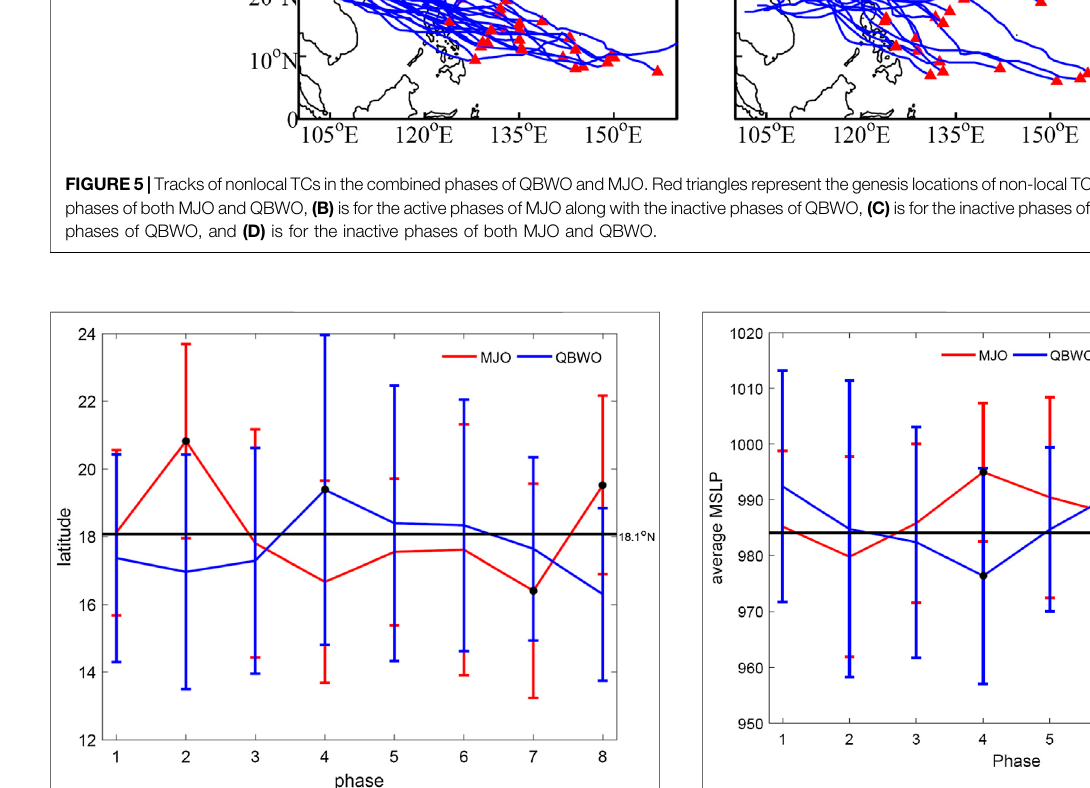
FIGURE6| ThemeanlatitudeanditsstandarddeviationofnonlocalTCs entering the SCS in each phase of MJO (blue) and QBWO (red). The black line indicates the mean entry location. The black dots indicate the values exceeding 95% con fi dence level basing on the Student ’ s t test.